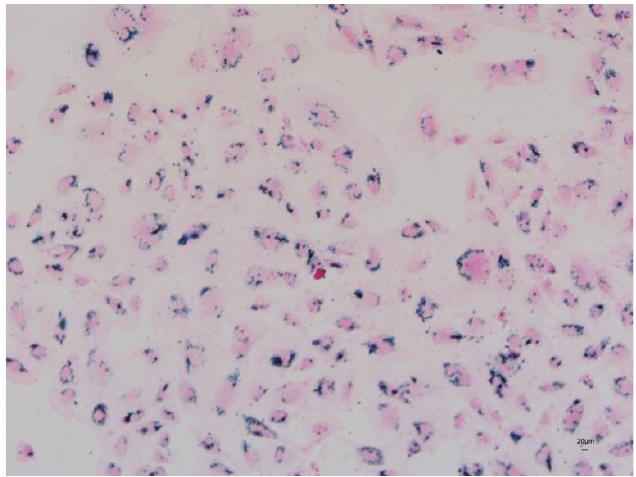
Figure 6. Prussian Blue staining of DPSCs labeled with 180 µg/mL of iron oxide and transfected with 1 µL/mL of lipofectamine to facilitate internalization of iron oxide nanoparticles that appear in blue color (4×).